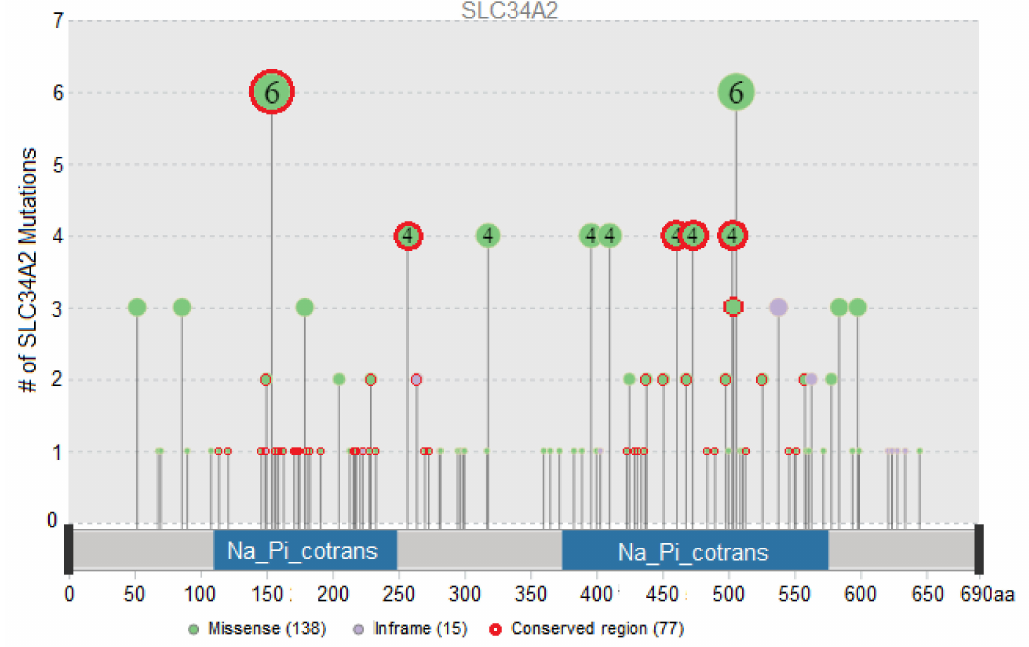
Figure 1. Functionally significant missense and indel mutations in the SLC34A2 gene detected in the tumor samples of three databases (cBioPortal, TCGA, Genie, ICGC; n = 98,533). The x-axis shows the position of the amino acid in the SLC34A2 protein sequence, the y-axis and the number of the dot represent the number of mutations found in the overall dataset, and the red outline of a dot indicates the conserved regions in the